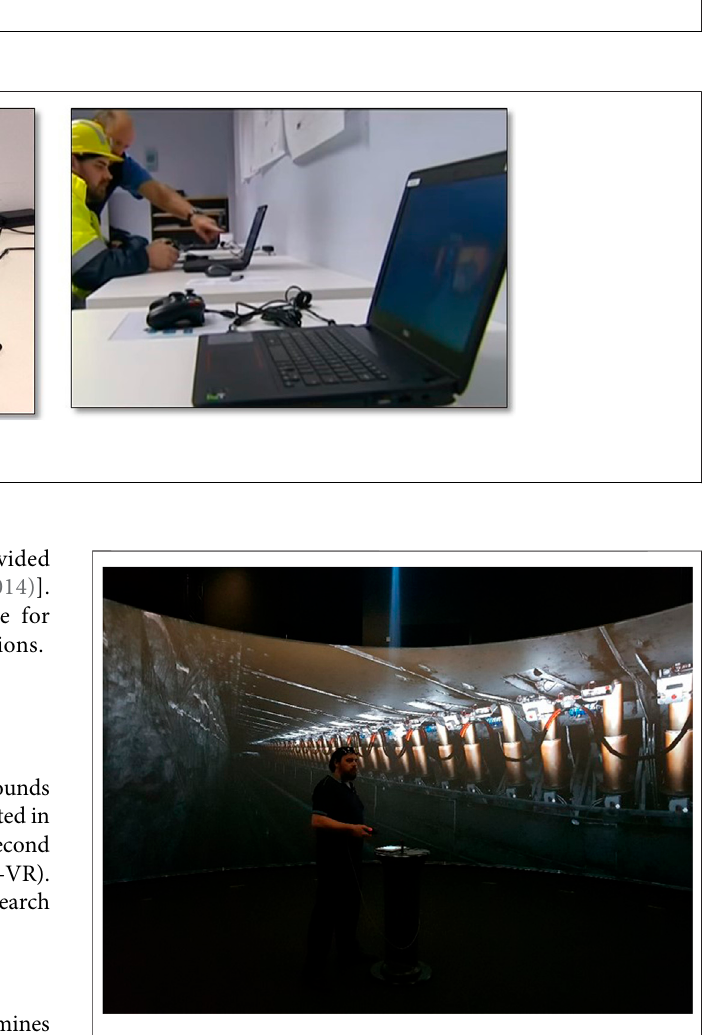
FIGURE 4 | The trainer in the 360-VR environment, operating Longwall mining machinery in the